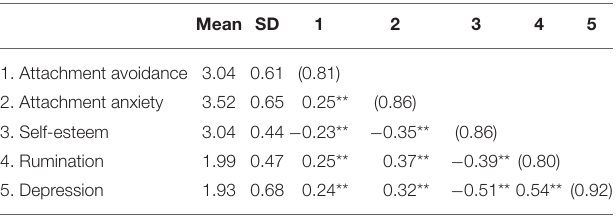
TABLE 1 | Descriptive statistics and correlation analysis of all the variable ( n =